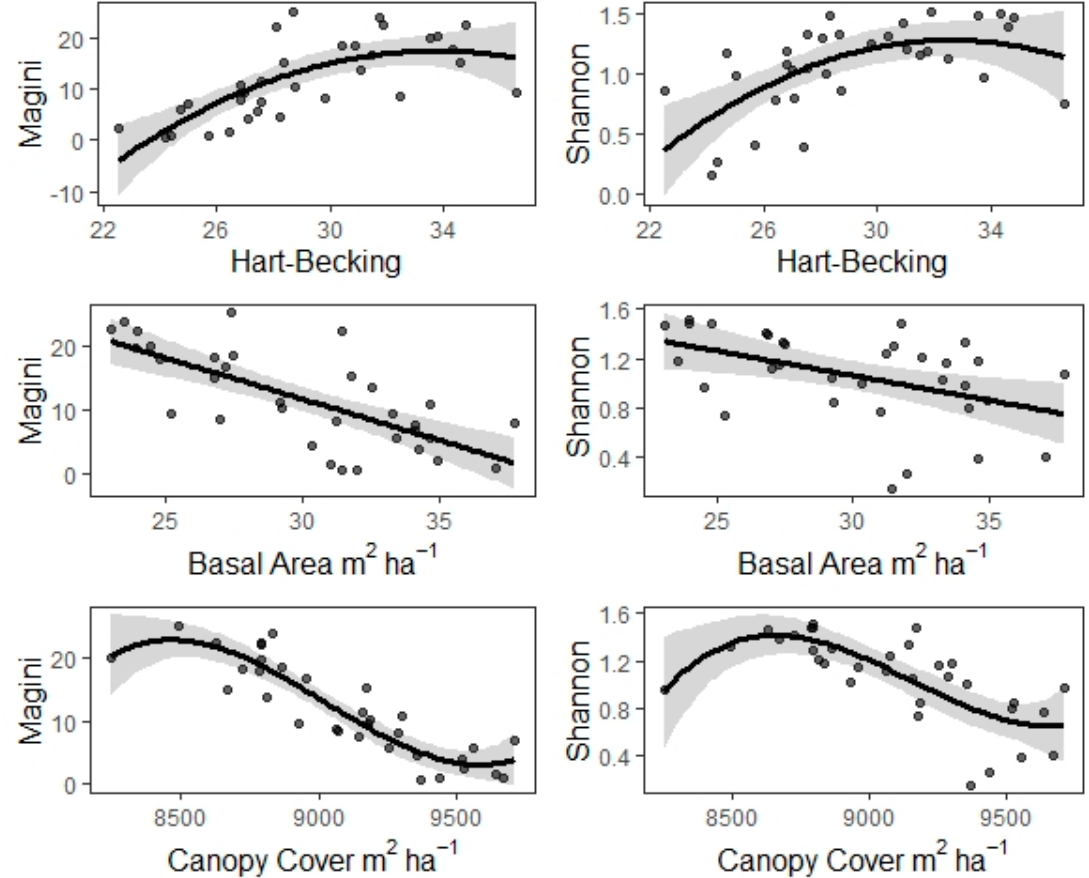
Figure 2. Polynomial fits and respective 95% confidence intervals for the Magini and Shannon indices as functions of the Hart–Becking spacing index, Basal Area and Canopy Cover. Dots represent the 33 sampling plots.